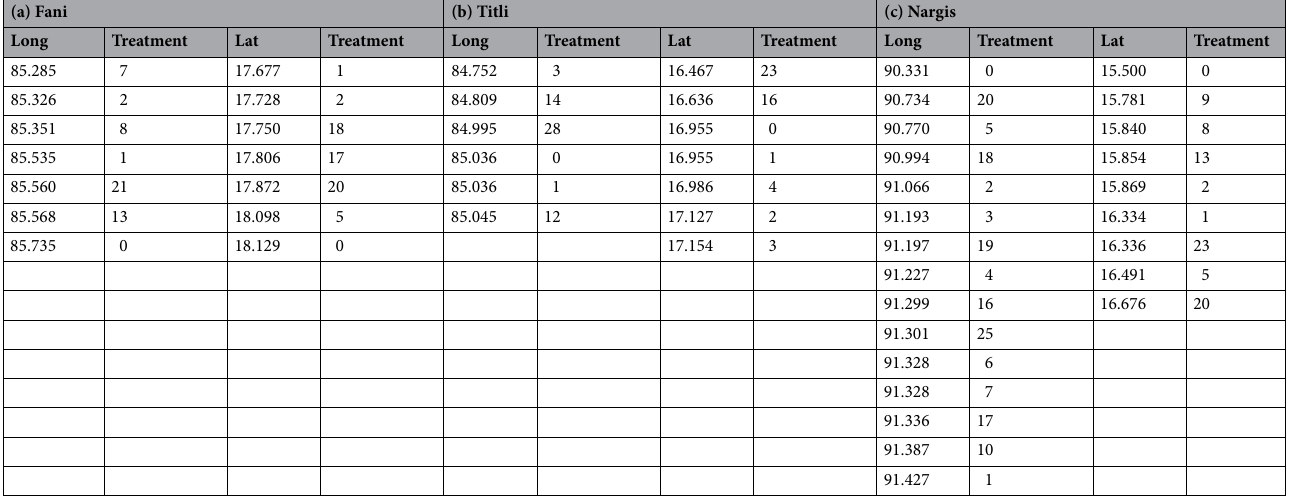
Table 15. Tukey post-hoc analysis for Longitude and Latitude for cyclone (a) Fani (b) Titli and (c)